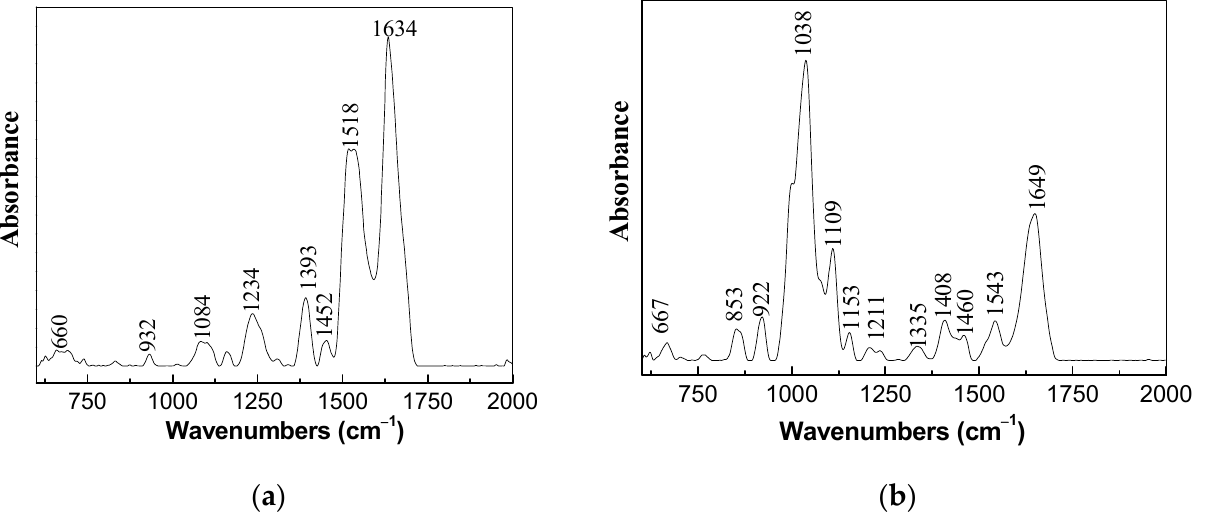
Figure 5. The IR spectrum of the protein G ( a ) and EGFR antibody ( b ).